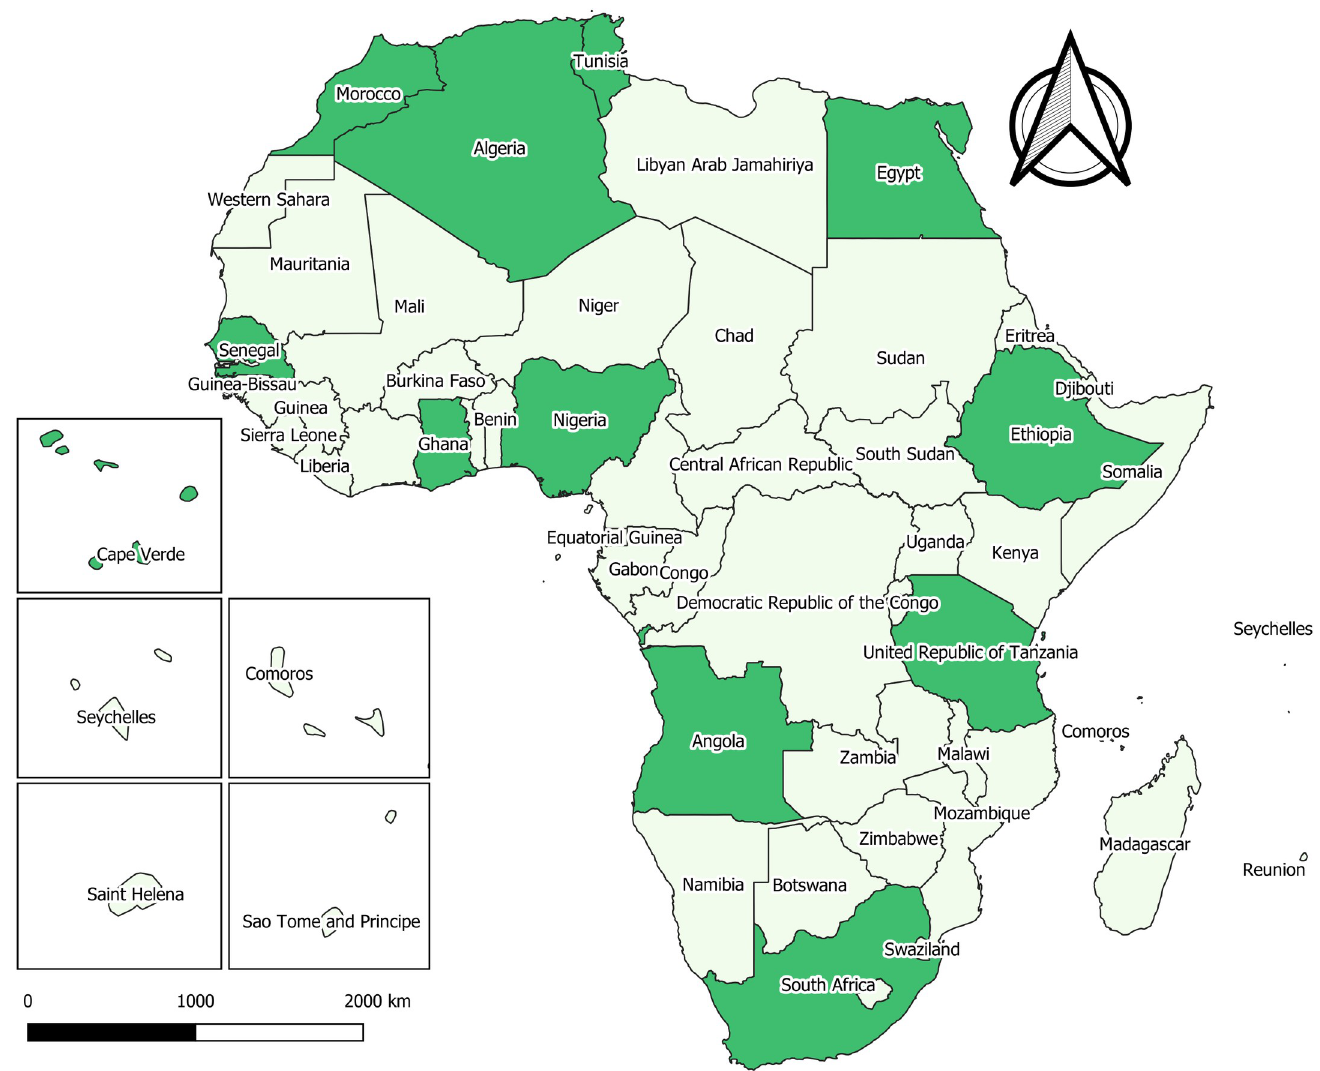
Fig 2. Distribution of human fascioliasis based on records retrieved in the systematic review. In dark green: presence reported, in light green: not reported or reported absent. Insert maps of islands are not presented on true scale. Shapefile republished from DIVA-GIS database (https://www.diva-gis.org/) under a CC BY license, with permission from Global Administrative Areas (GADM), original copyright